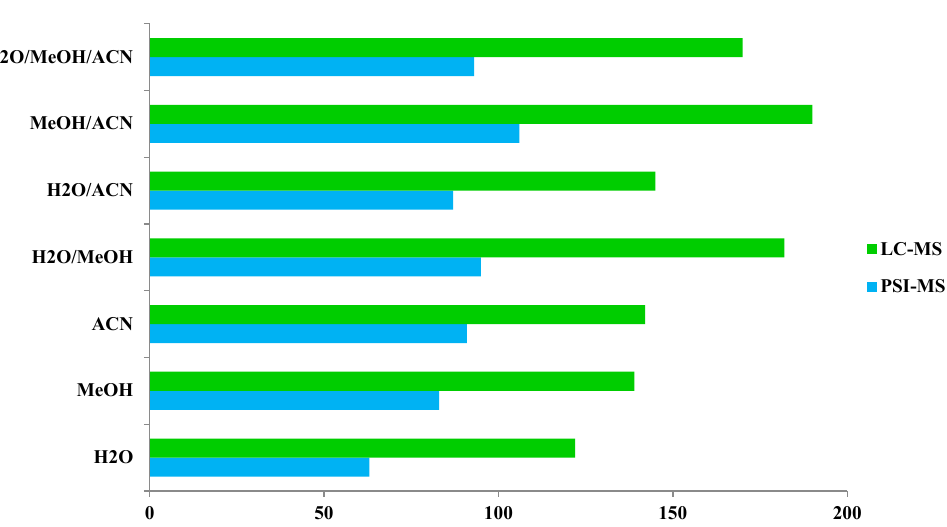
Figure 4. Comparison of the number of compounds detected by paper spray ionization mass spectrometry (PSI-MS) and liquid chromatography–mass spectrometry (LC-MS) in the different cupuassu pulp extracts.